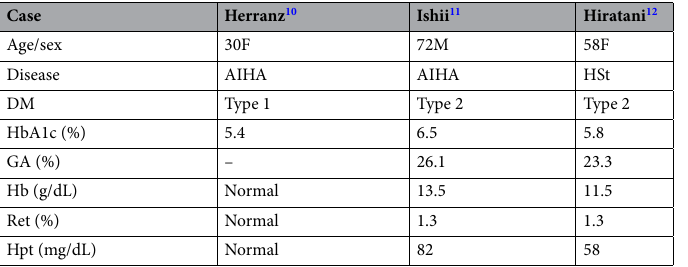
Table 2. Characteristics of three reported patients with latent hemolysis and DM in literature. These patients showed normal Hb, reticulocyte, and haptogloblin. AIHA, autoimmune hemolytic anemia; HSt, hereditary stomatocytosis, DM, diabetes mellitus; GA, glycated albumin; Hb, hemoglobin; Ret, reticulocyte; Hpt, haptoglobin.